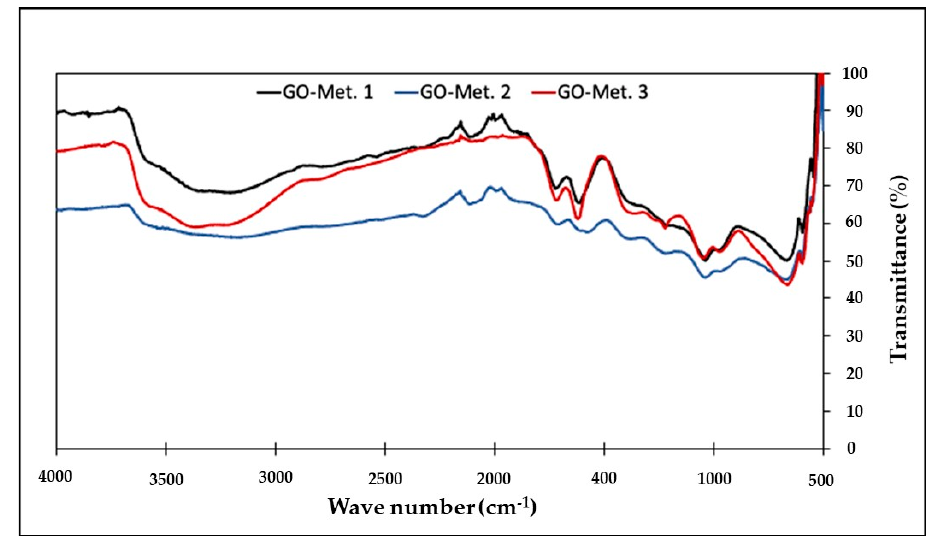
Figure 2. FTIR spectrum of the GO samples analysed.